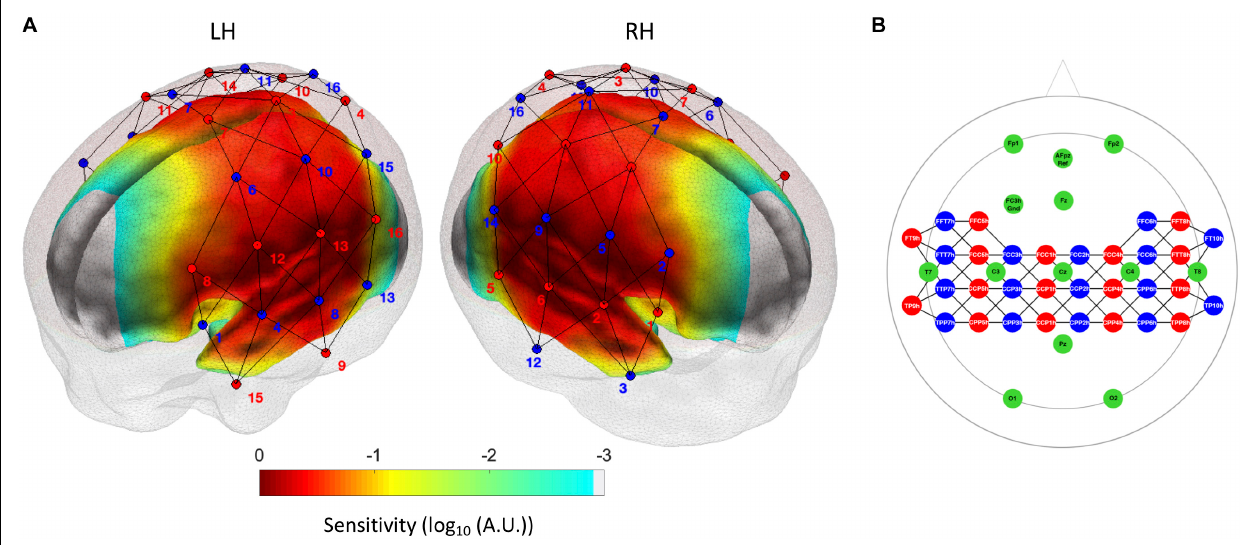
FIGURE 1 | (A) Optode localization (sources in red and detectors in blue) in the current experimental setup. The normalized sensitivity profile of this configuration is displayed on a neonate head model template (Brigadoi et al., 2014), where regions of higher sensitivity below the source-detector configuration are displayed in red color. (B) fNIRS optode and EEG electrode positions in the 10–5 system for the EasyCap montage employed in the current study. The fNIRS sources are indicated in red, the detectors in blue, and the EEG electrodes in green.